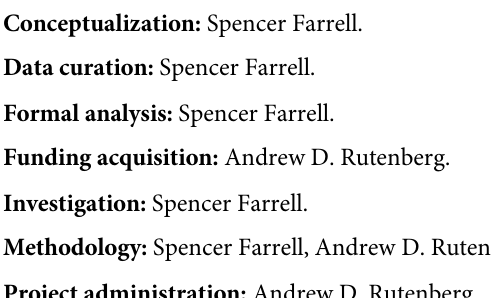
S14 Fig. Comparison with correlation network. a) Pearson correlation network between the health variables for all individuals at all time-points, values are pruned for p-values above 0.01. b) Our model interaction network, for comparison. Weights are pruned when the 99% poste- rior credible interval includes zero. S15 Fig. Testing deprivatization of ELSA ages. All known unprivatized ages past the first age for each individual in the ELSA dataset are set to missing. This allows us to test our approach to deprivatizing ages above 90, using the known ages below 90. a) Scatter plot of observed age vs deprivatized age. The green dashed light highlights perfect deprivatization. All errors are within 3 years, except for the three highlighted red points for 3 different individuals. For these individuals, we suspect a data error. For one of these individuals their observed age only advances 1 year over 5 waves, for another their age advances 15 years over 2 waves, and for the third their age advances 7 years over 1 wave. b) Dropping these three red points, we show that the mean absolute error with this approach is 0.23 years, and the maximum error is 3 years. The histogram shows that for the vast majority of individuals, there is a 0 to 1 year error with this method of deprivatization. S16 Fig. DJIN model trained with and without replicated individuals. a) Time-dependent C-index stratified vs age (points) and for all ages (line). Results are shown for the DJIN model trained without replicated individuals (purple), the DJIN model trained with replicated indi- viduals shown in the main results (red) and a Elastic net Cox model (green). (Higher scores are better). b) Brier scores for the survival function vs death age. Integrated Brier scores (IBS) over the full range of death ages is also shown. The Breslow estimator is used for the baseline hazard in the Cox model (Cox-Br). (Lower scores are better). c) RMSE scores when the base- line value is observed for each health variable for predictions at least 5 years from baseline, scaled by the RMSE score from the age and sex dependent sample mean (relative RMSE scores). We show the predictions from the DJIN model trained without replicated individuals starting from the baseline value (purple stars), the DJIN model trained with replicated individ- uals (red circles), predictions assuming a static baseline value (blue diamonds), an elastic-net linear model (green squares). (Lower is better). d) Relative RMSE scores when the when the baseline value for each health variable is imputed for predictions past 5 years from baseline. We show the predictions from the DJIN model trained without replicated individuals starting from the imputed value (purple stars), our DJIN model trained with replicated individuals (red circles), and predictions with an elastic-net linear model (green